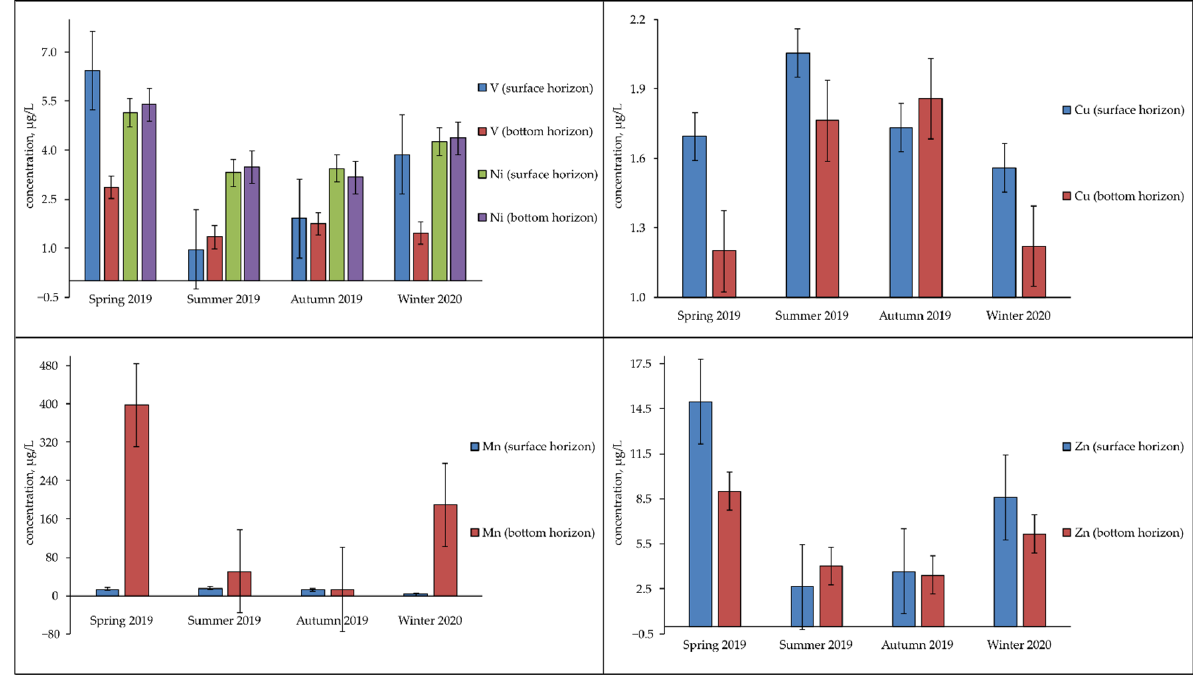
Figure 4. Seasonal and vertical variation of V, Ni, Mn, Cu, Zn contents in Lake Semenovskoe in 2019–2020 .